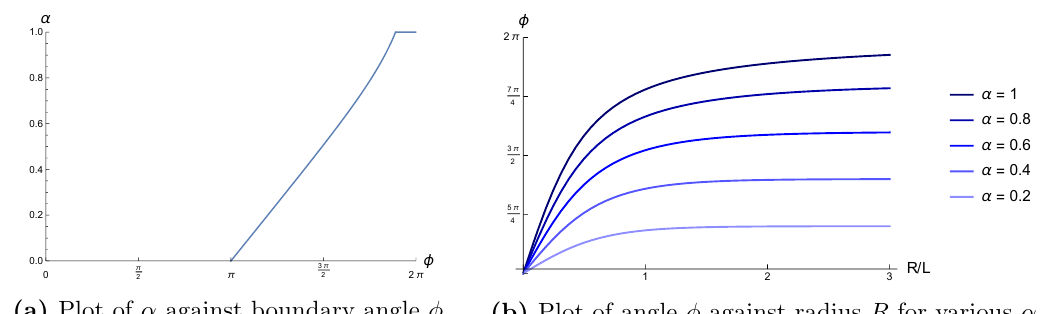
(a) Plot of (cid:11) against boundary angle (cid:30) . (b) Plot of angle (cid:30) against radius R for various (cid:11) . Figure 6 . (a) (cid:11) smoothly increases as we increase the size of the boundary region A (with angle (cid:30) ). The black hole is a BTZ black hole with horizon radius R = 2 L . The boundary encodes no information about region a 0 for (cid:30) < (cid:25) . For (cid:30) > (cid:25) , it contains the (cid:11) -bits for increasingly large (cid:11) , until eventually (cid:11) = 1 and the region a 0 can be decoded without any knowledge of the black hole microstate. (b) The angle (cid:30) of the boundary region A required to decode the bulk region a 0